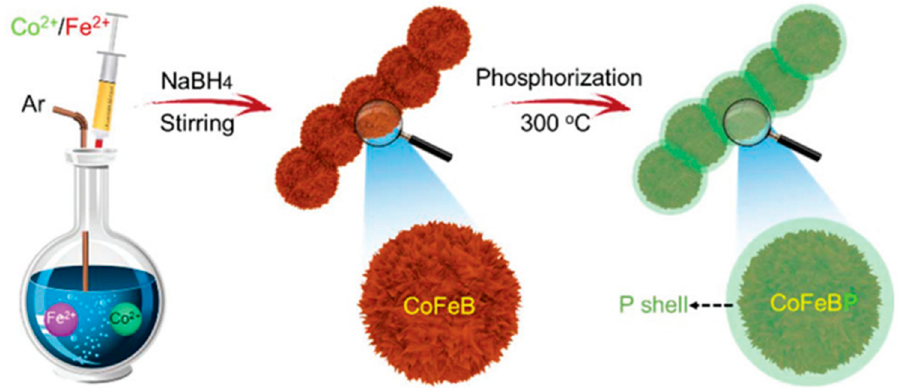
Figure 1. Schematic synthesis process of the Co 1 –Fe 1 –B–P nanochains, reproduced with permission from [19]. Copyright Royal Society of Chemistry, 2019.